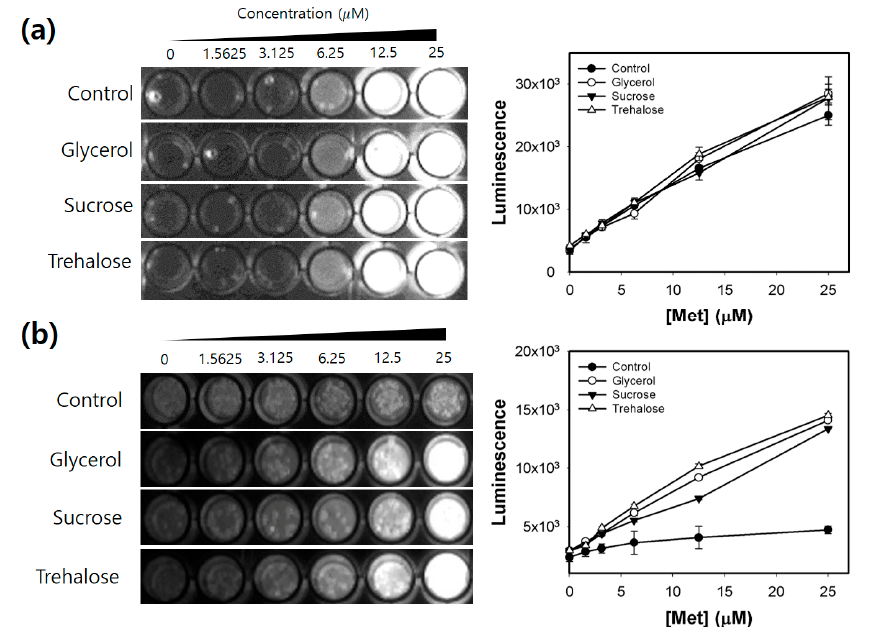
Figure 5. Luminescence images of the amino acid arrays containing glycerol, sucrose, and trehalose as a cryoprotectant and the calibration curves of methionine (Met) (plotted as concentration vs. luminescence intensity) generated using these arrays ( a ) before and ( b ) after storage for 3 months. Error bars represent standard errors derived from three independent measurements.